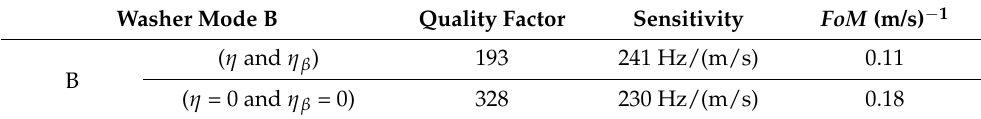
Figure 4. Transmission curves of the acoustic liquid sensor evaluated on ( a ) the transmission region and ( b ) the washer. The black curve corresponds to water, while the red and the green curves correspond to a change of 1% in the sound velocity c l and the mass density ρ of the water, respectively. Table 1. Quality factor, sensitivity, and figure of merit of the sensor, including or excluding the viscosity. Washer Mode B Quality